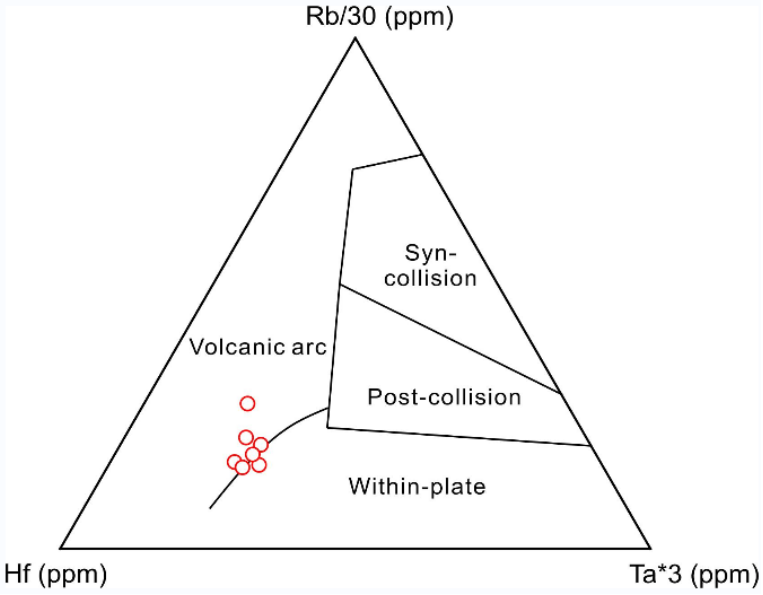
Figure 14. Hf–Rb/30-Ta*3 diagram [33] of the Kangjiali gneissic granite. The source regions of the peraluminous volcanic rocks occurring in convergent margins have been variably attributed, including restite unmixing or peritectic assemblage entrainment [34], mafic lower crust [35,36] and subducting oceanic slab [37]. The absence of restitic/peritectic phases such as garnets and pyroxenes or restitic xenoliths precludes the restite unmixing and peritectic assemblage entrainment genesis. The evolved Sr–Nd isotopic compositions of these peraluminous granites is like the involvement of subducted oceanic slab melting in their genesis rather than mafic lower crust derivation. values (39.93–46.89) and peraluminous characteristics (Figure 5), which is consistent with granites from partial melting of lower crustal materials. In addition, the Kangjiali